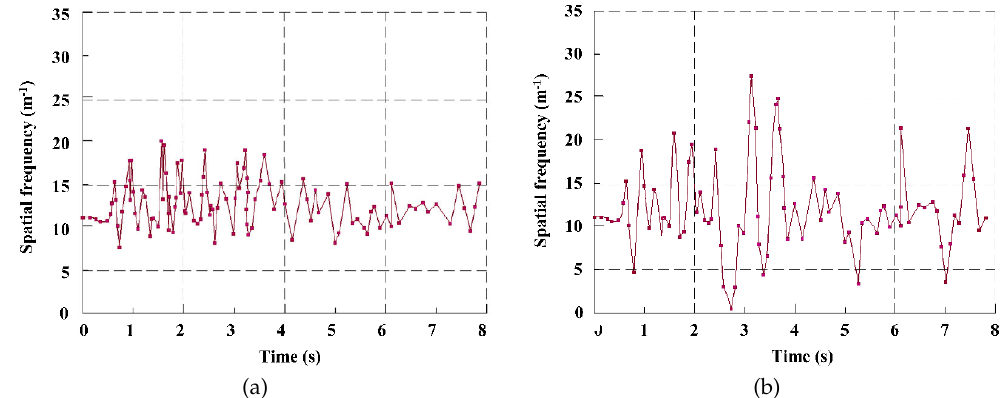
Fig. 6. The spatial frequency with time before and after the test; (a)Spatial frequency changes before the test; (b)Spatial